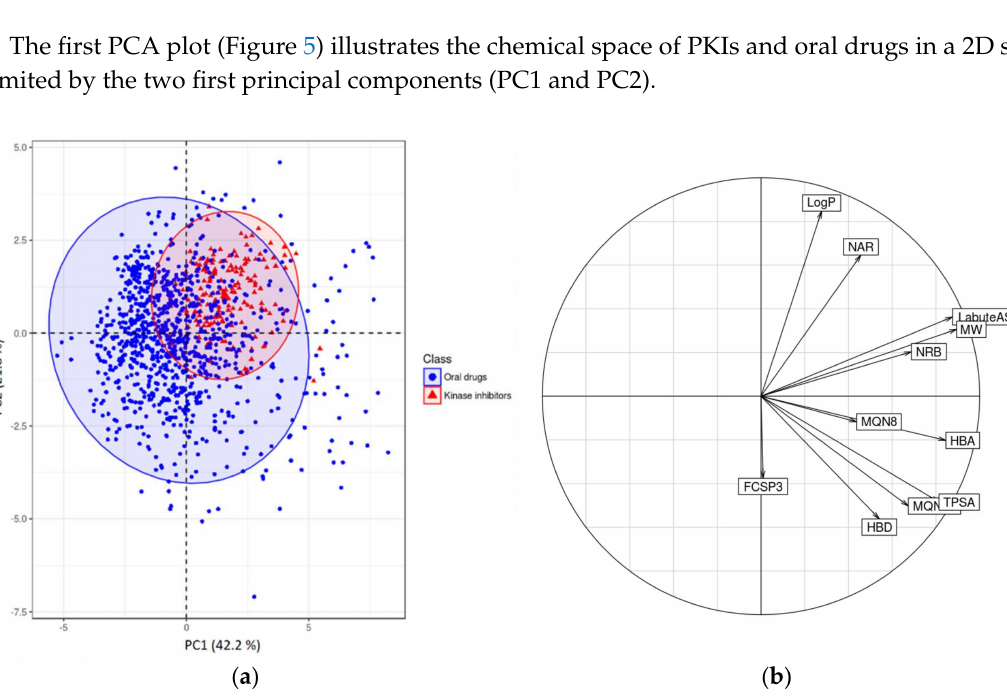
Figure 5. ( a ) PCA of FDA orally approved drugs and PKIDB containing 180 PKIs. Blue and red ellipses encompass 95% of the individuals from class “Oral drugs” and “Kinase inhibitors” respectively; ( b ) Corresponding correlation